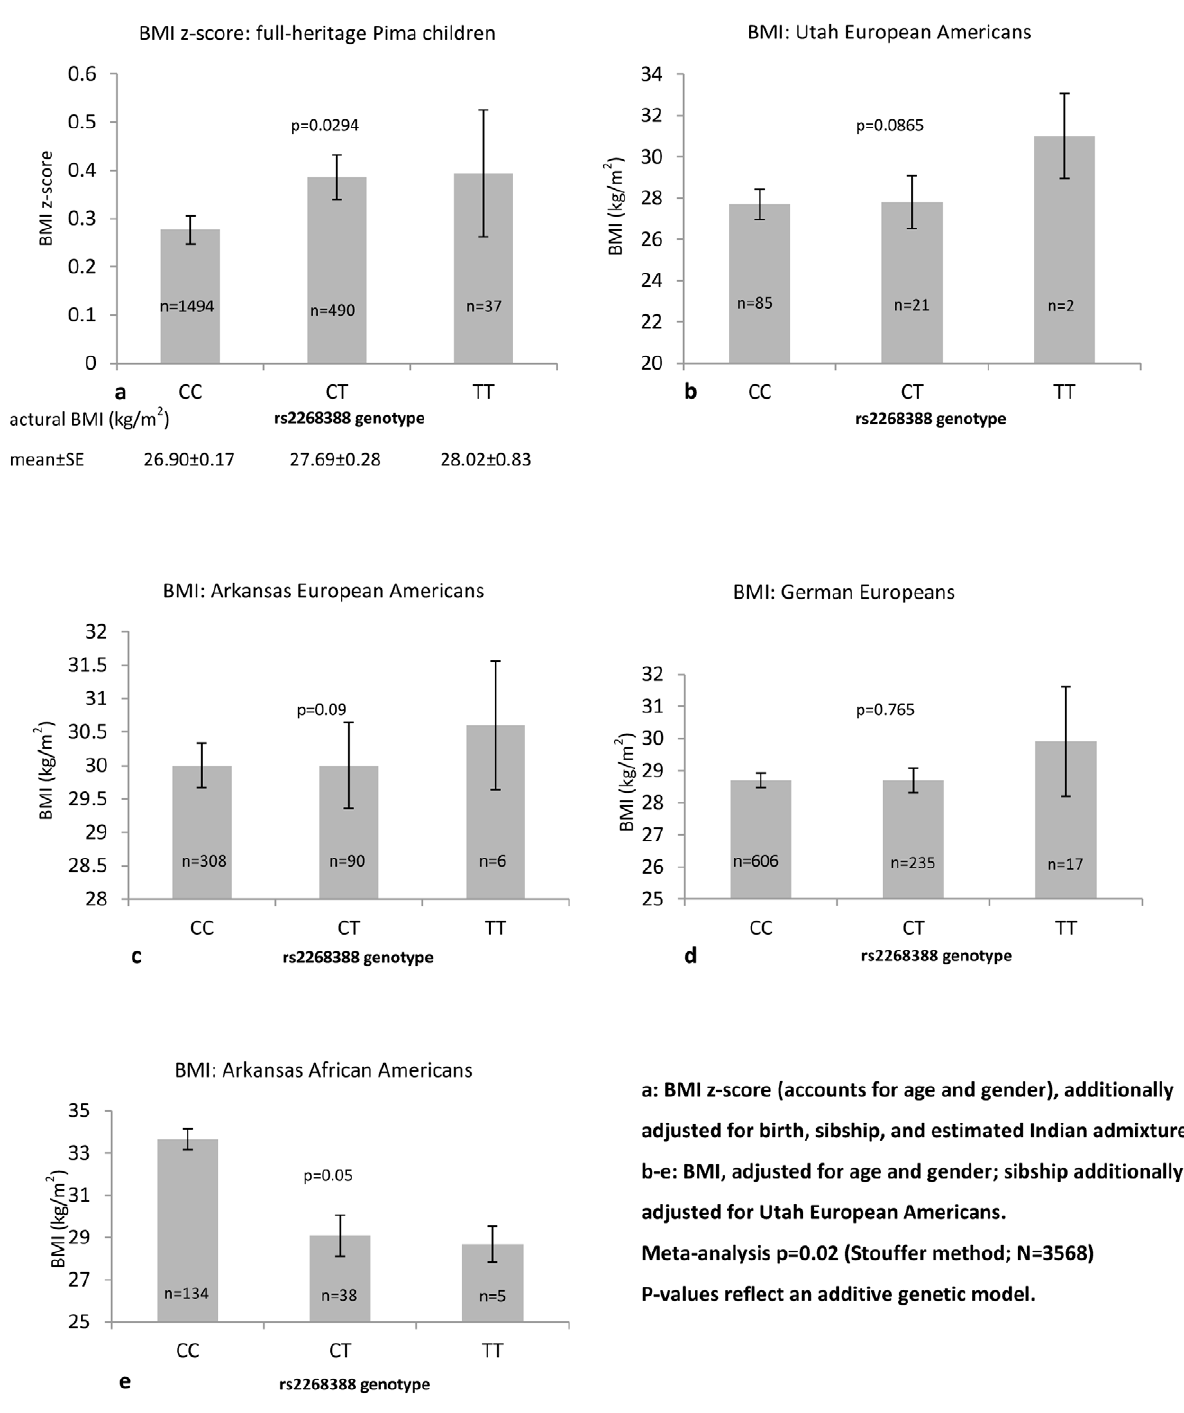
Figure 1. Association of rs2268388 with BMI in non-diabetic subjects.